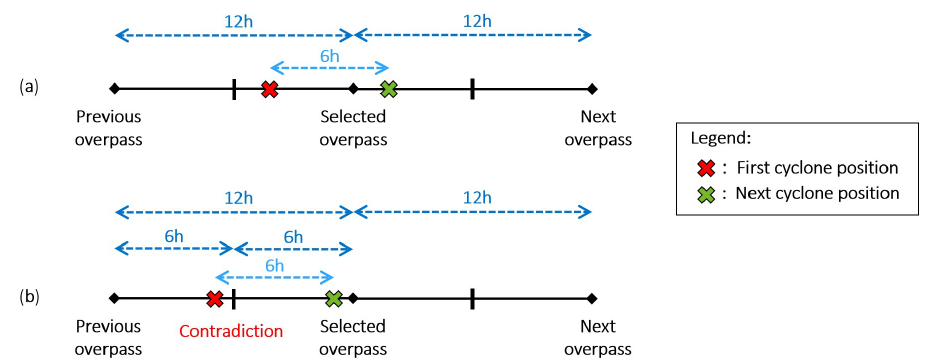
Figure A3. Timeline when two TC positions are matched to the same IASI overpass. ( a )